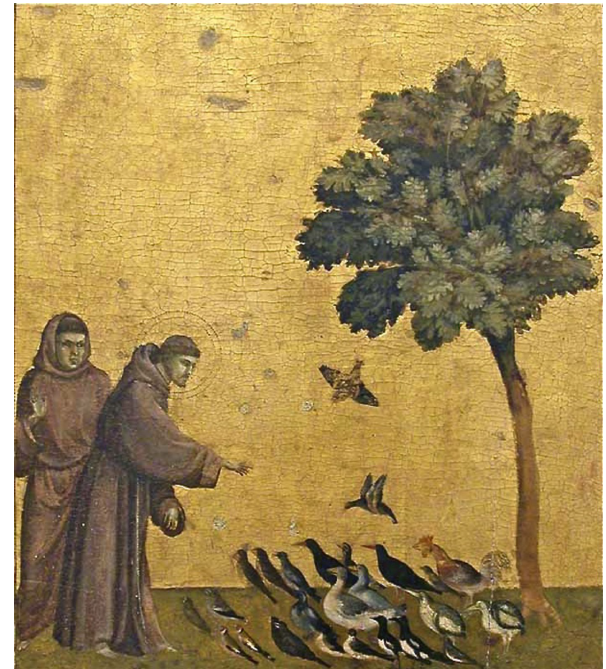
Figure 14. St. Francis preaching to the birds by Giotto (1295– 1300). Now at the Louvre Museum, Paris, France. Source: public domain – Wiki Commons.